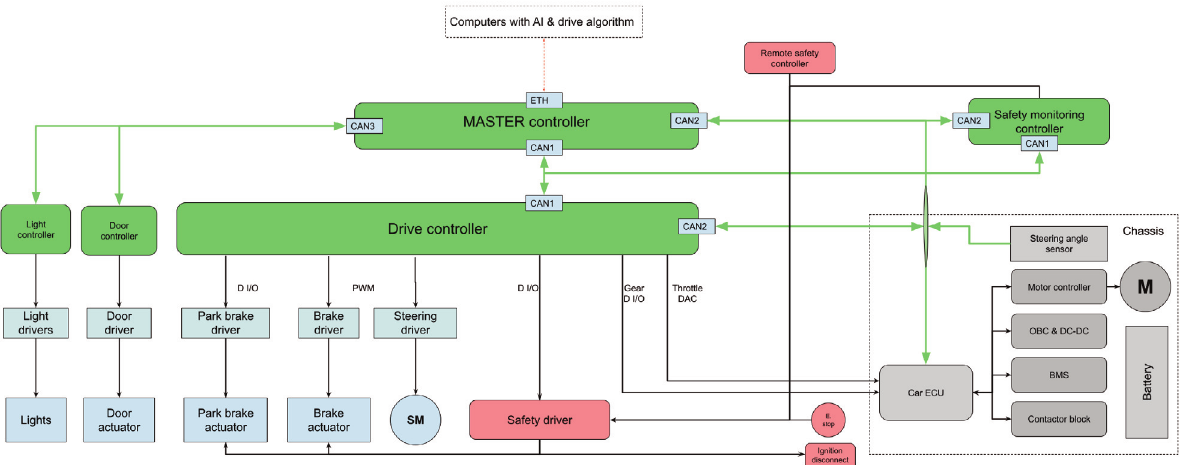
Fig. 1. Low-level control solution for TalTech iseAuto. ETH – Ethernet; CAN – Controller Area Network; D I/O – digital input/output; PWM – pulse-width modulation; DAC – digital-to-analog converter; OBC – onboard charger; DC-DC – direct current to direct current converter; SM – steering motor; E. stop – emergency stop; ECU – electric control unit; BMS – battery management system.